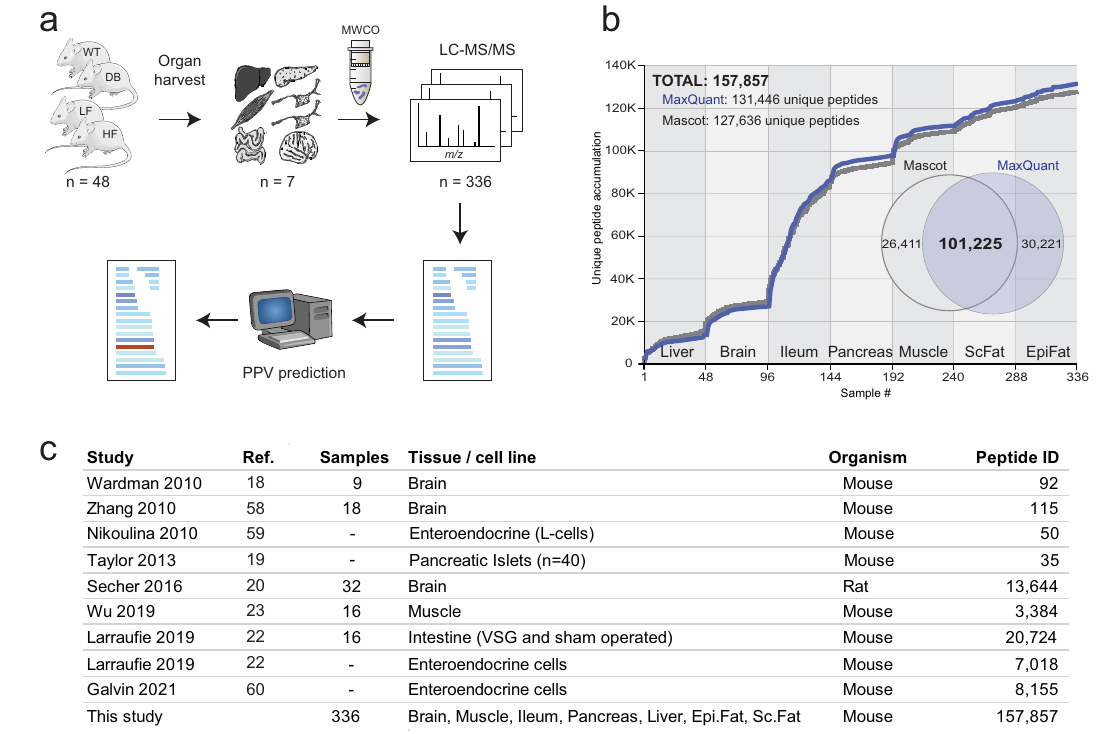
Fig. 1 | Experimental setup and data overview. a Age synchronized mice ( n =12 each) of wildtype (WT), diabetic (DB), low-fat diet (LF), high-fat diet (HF) back- ground were sacri fi ced and 7 organs collected. To minimize background inter- ferencefrom proteinand peptide degradation, tissue sampleswere heatstabilized usingaDenatorT1heat-stabilizor.Peptideswereenrichedusingamolecularweight cut-off fi lter (MWCO) and the resulting raw fi les processed using the Mascot and MaxQuantsearchengines.ThePredicted-PeptideVariant(PPV)algorithmhighlight